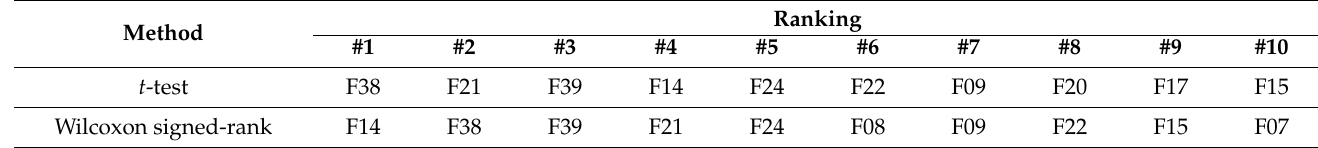
Figure 4. ( a ): Box plot of energy and power features. ( b ): Projected data points of benign and malignant classes using CyEfF. Table 3. Feature ranking results: F 01- F 24: GF, F 25- F 37: EF and F 38, F 39: